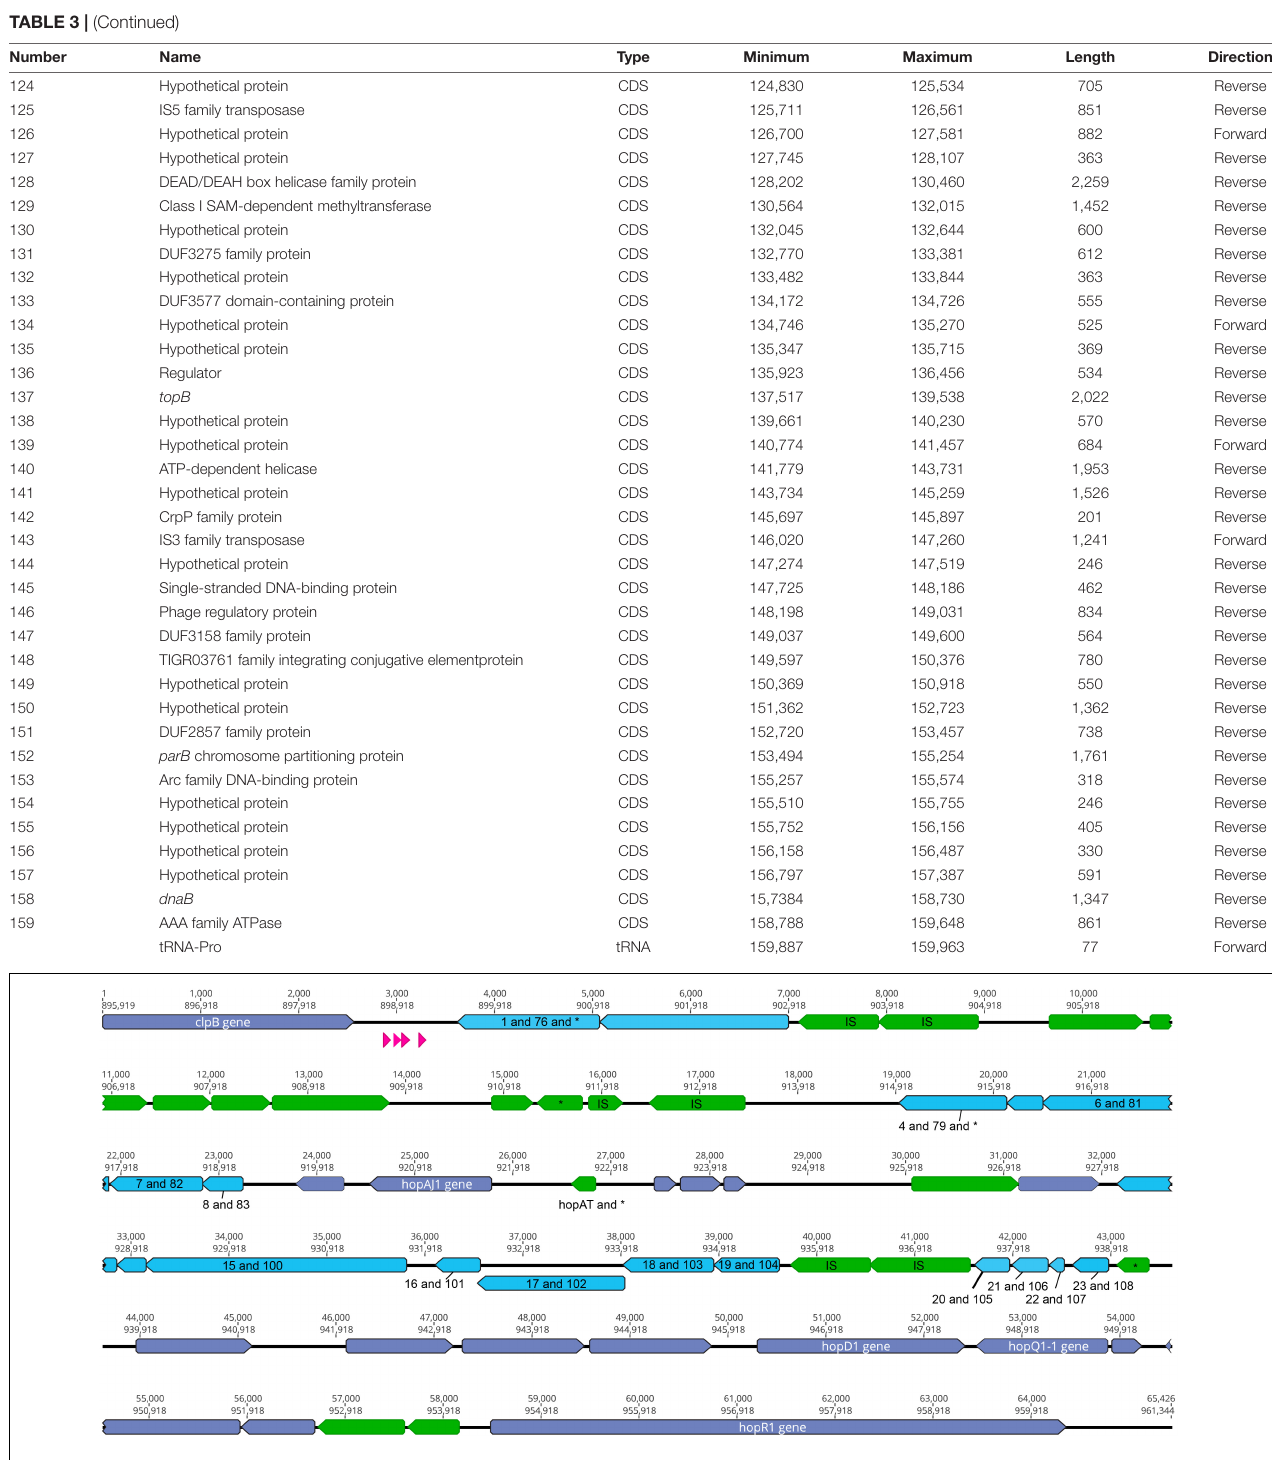
FIGURE 2 | The clpB-hopR Region in Pto DC3000. Here we visualize the region between clpB and hopR from the Pto DC3000 genome, and compare this region to both predicted ICE elements from Pma ES4326. Each predicted locus is colored as purple (present in one of the Pma ES4326 ICE elements), blue (present in both Pma ES4326 ICE elements as per nucleotide identity), and green (only present in Pto DC3000). Predicted tRNA loci are shown in magenta. We also show two nucleotide positions within this region: top number is from the start of clpB and the bottom number is from the start of the genome (from dnaA ). We label all identified type III effector loci and clpB , as well as all annotated IS elements (with an “IS”) and genes that have predicted frameshifts (with an “*”). All genes potentially implicated in ICE function have been labeled with numbers corresponding to potential orthologs from strain Pma ES4326 ICEs and listed in Table 3 .